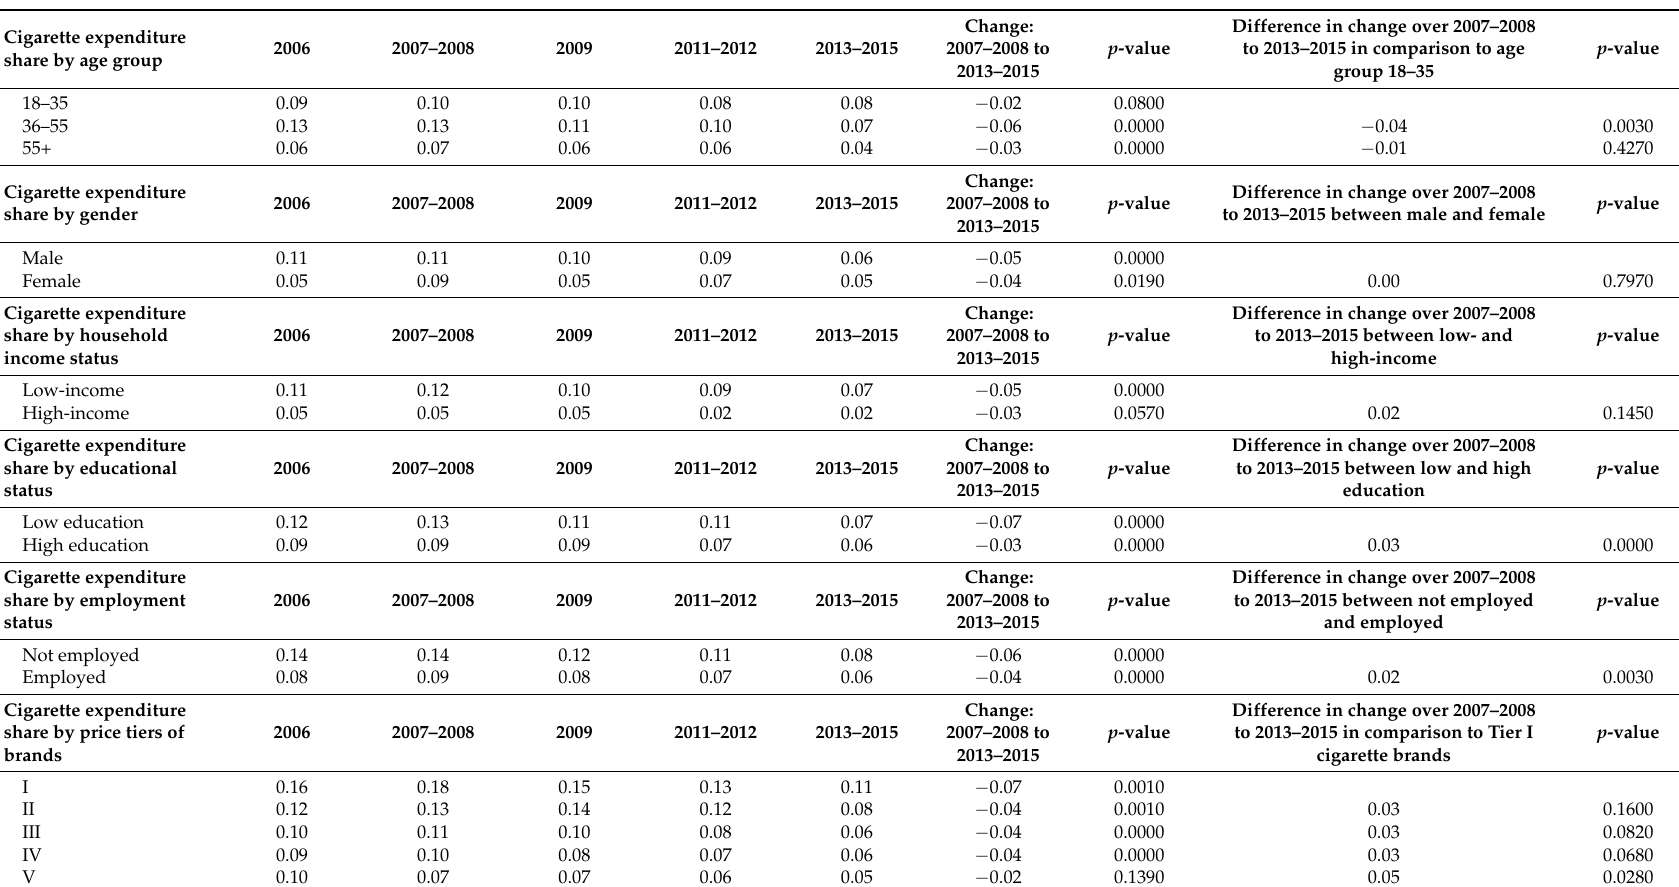
Table 9. Trend in cigarette expenditure share in smokers’ household income (predicted from GEE estimation) by age, gender, household income status, education, employment status and price tier of brands in last purchase of smokers in China, 2007–2008 to